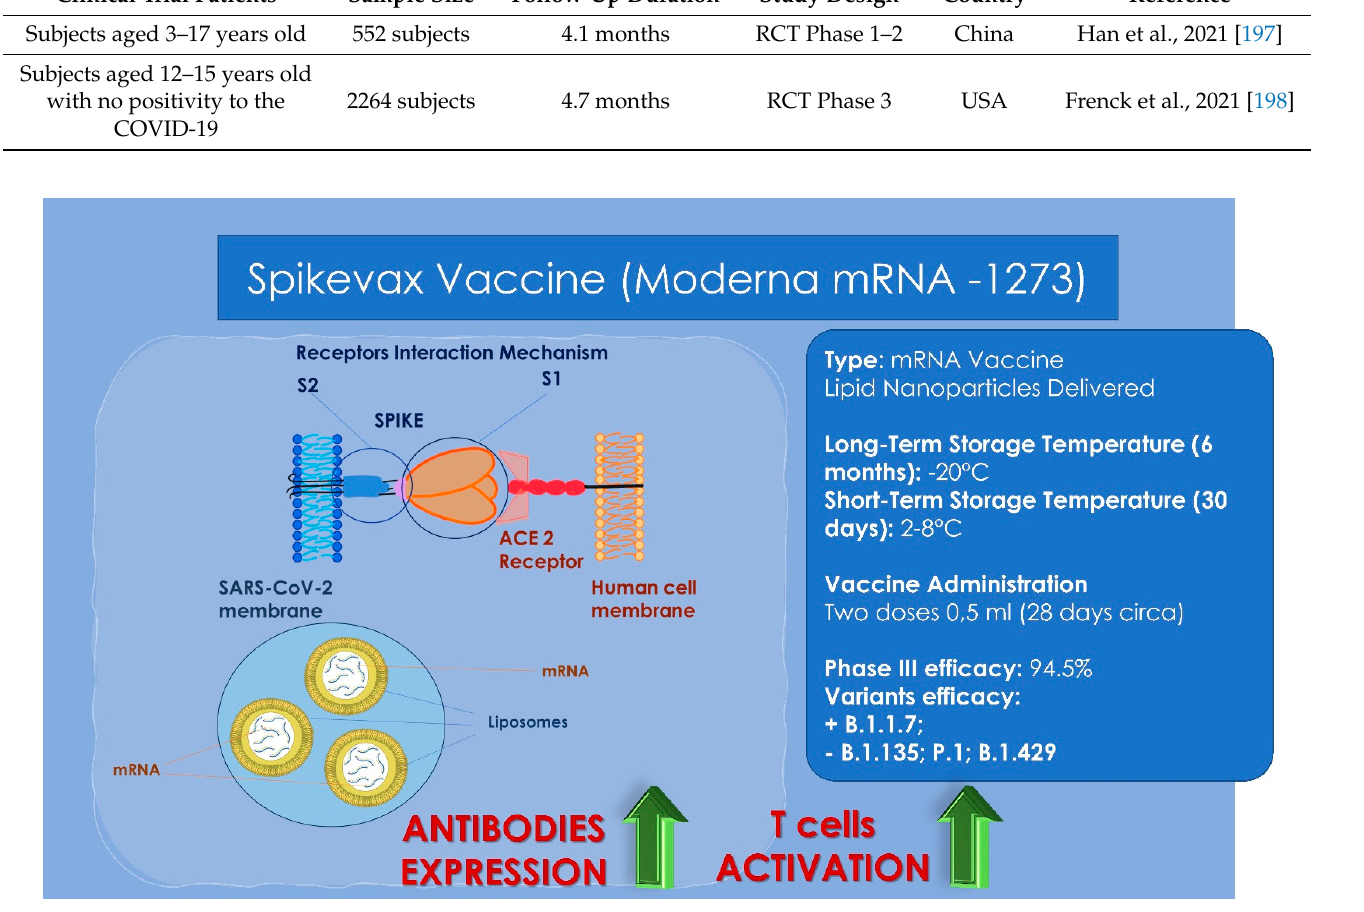
Figure 3. Moderna vaccine general characteristics, storage properties, administration dosages and variants’ efficacy. High: the receptors key-to-enter interaction mechanisms between the viral vector and the human host cell membrane. Low: the lipid-based nanoparticle with the mRNA is able to enter through a cellular endosome into the human cell. Inside the cell, the ionizable lipidic component of the endosome membrane is able to become charged positively producing a release of the lipid-based nanoparticle and mRNA into the cytoplasm. Then the ribosomes is able to synthetize proteins and messengers from mRNA producing an increase of the antibodies’ expression and an activation of the T cells’ response.